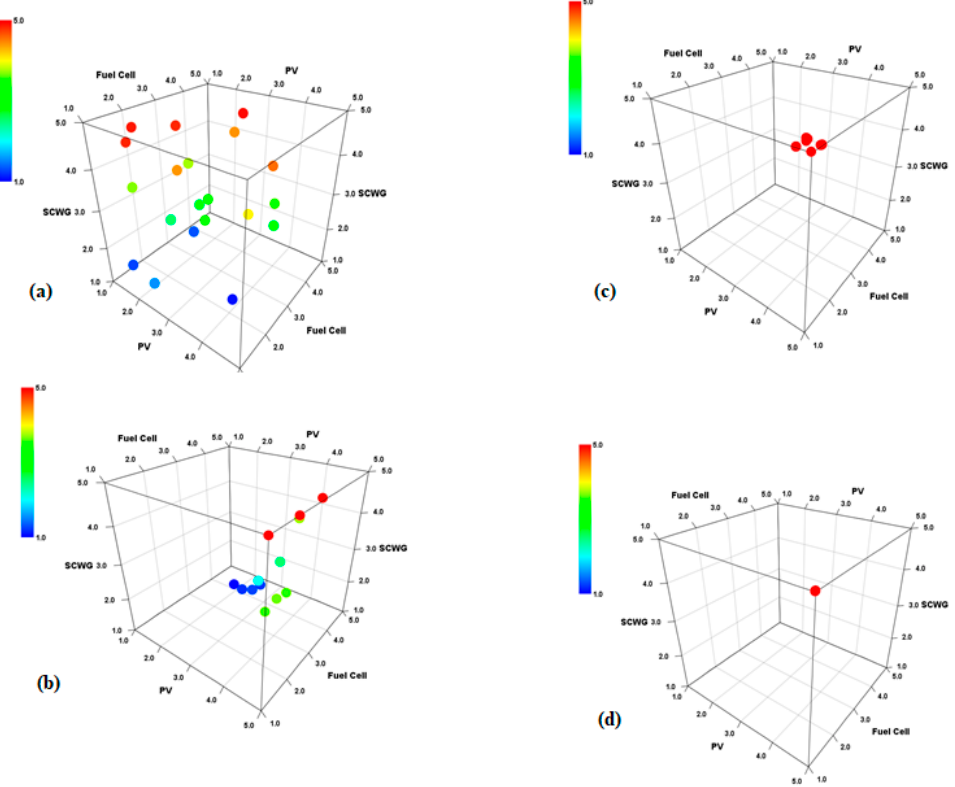
Figure 12. Particle positions (PV vs. fuel cell vs. SCWG) in different iterations: ( a ) = 0, ( b ) = 3, ( c ) = 9, ( d ) = 20.